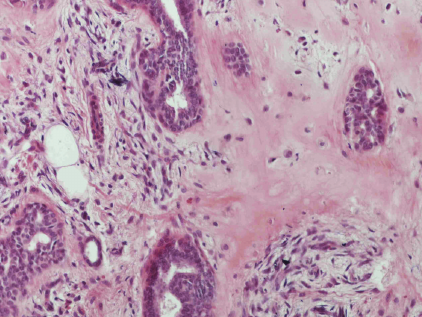
Figure 6: myoepithelial cells.